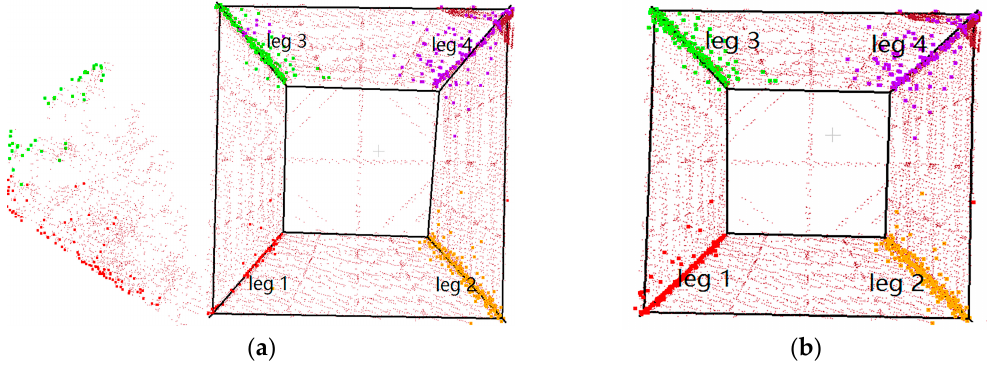
Figure 14. Comparison of the pylon body reconstruction in two situations: ( a ) the top view of the pylon with vegetation points effect; and ( b ) the same pylon without vegetation points effect.